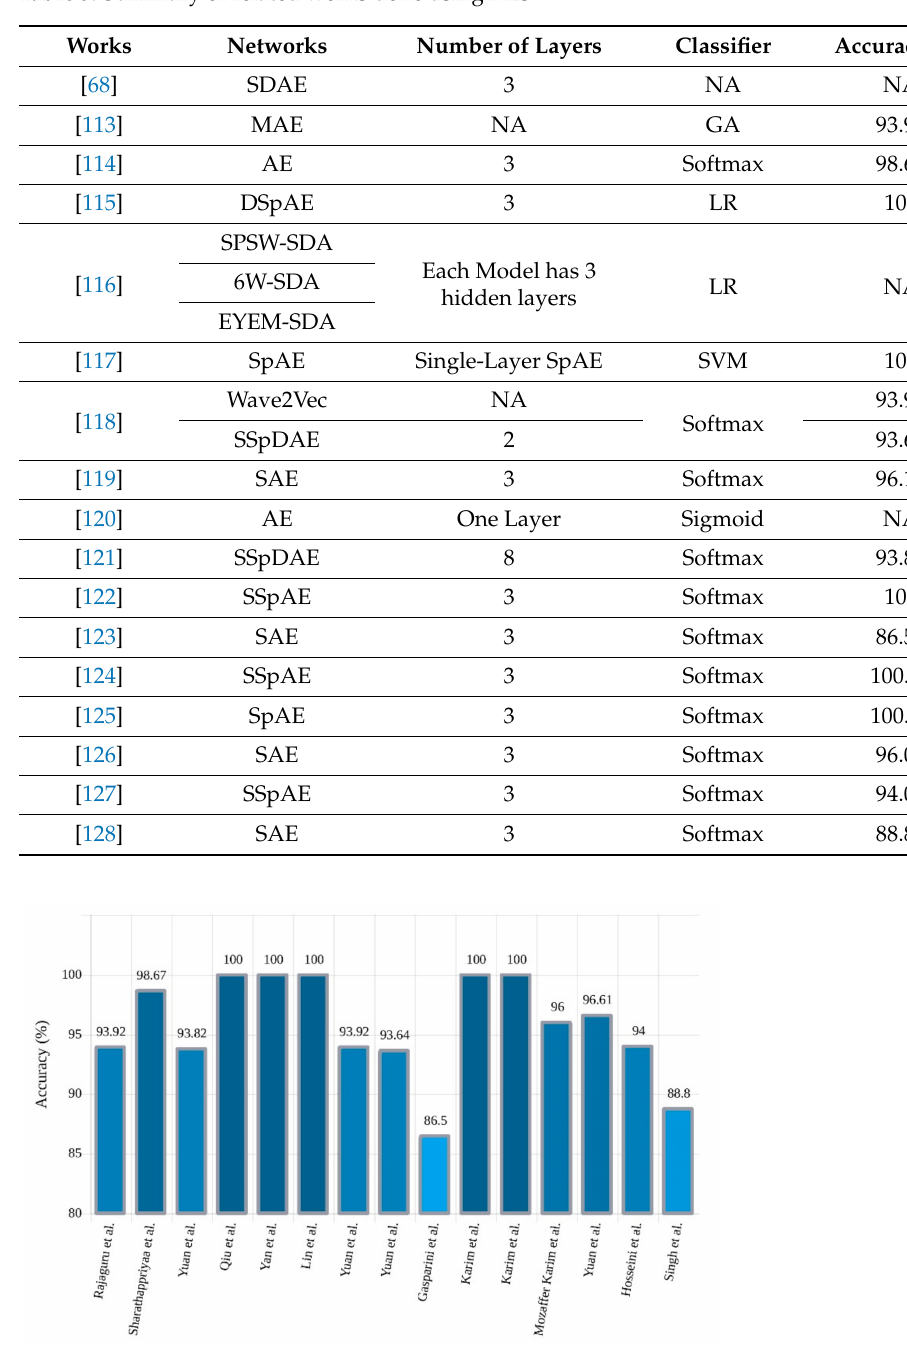
Figure 13. Sketch of accuracy (%) versus authors obtained using AE models for seizure